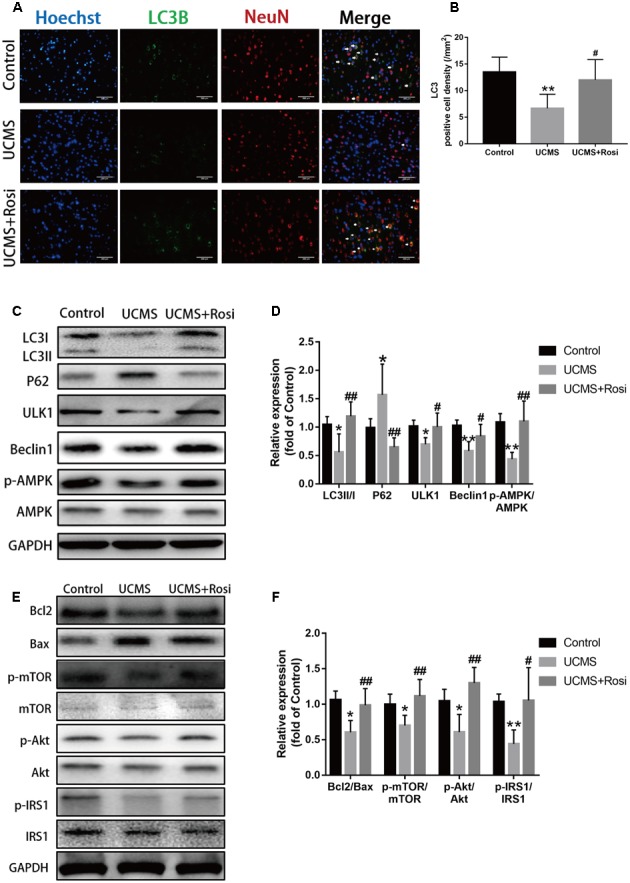
Autophagy- and apoptosis-related proteins are mediated by rosiglitazone administration. (A) Labeling of LC3B onto neurons in the sections and (B) counting the number of positive cells. (C,D) Analysis of autophagy-associated proteins LC3, P62, ULK1, Beclin 1, and p-AMPK/AMPK. (E,F) Western blotting analyzed the expression of Bcl2 Bax, and detected the ratio of p-mTOR, p-Akt and p-IRS1, GAPDH as a loading control. Data are presented as means ± SEMs; n = 5–6 for WB and n = 8–10 for IF. ∗p < 0.05 vs. control, ∗∗p < 0.01 vs. control, ∗∗∗p < 0.001 vs. control, #p < 0.05 vs. UCMS, ##p < 0.01 vs. UCMS, ###p < 0.001 vs. UCMS. UCMS+Rosi, rosiglitazone-treated UCMS.